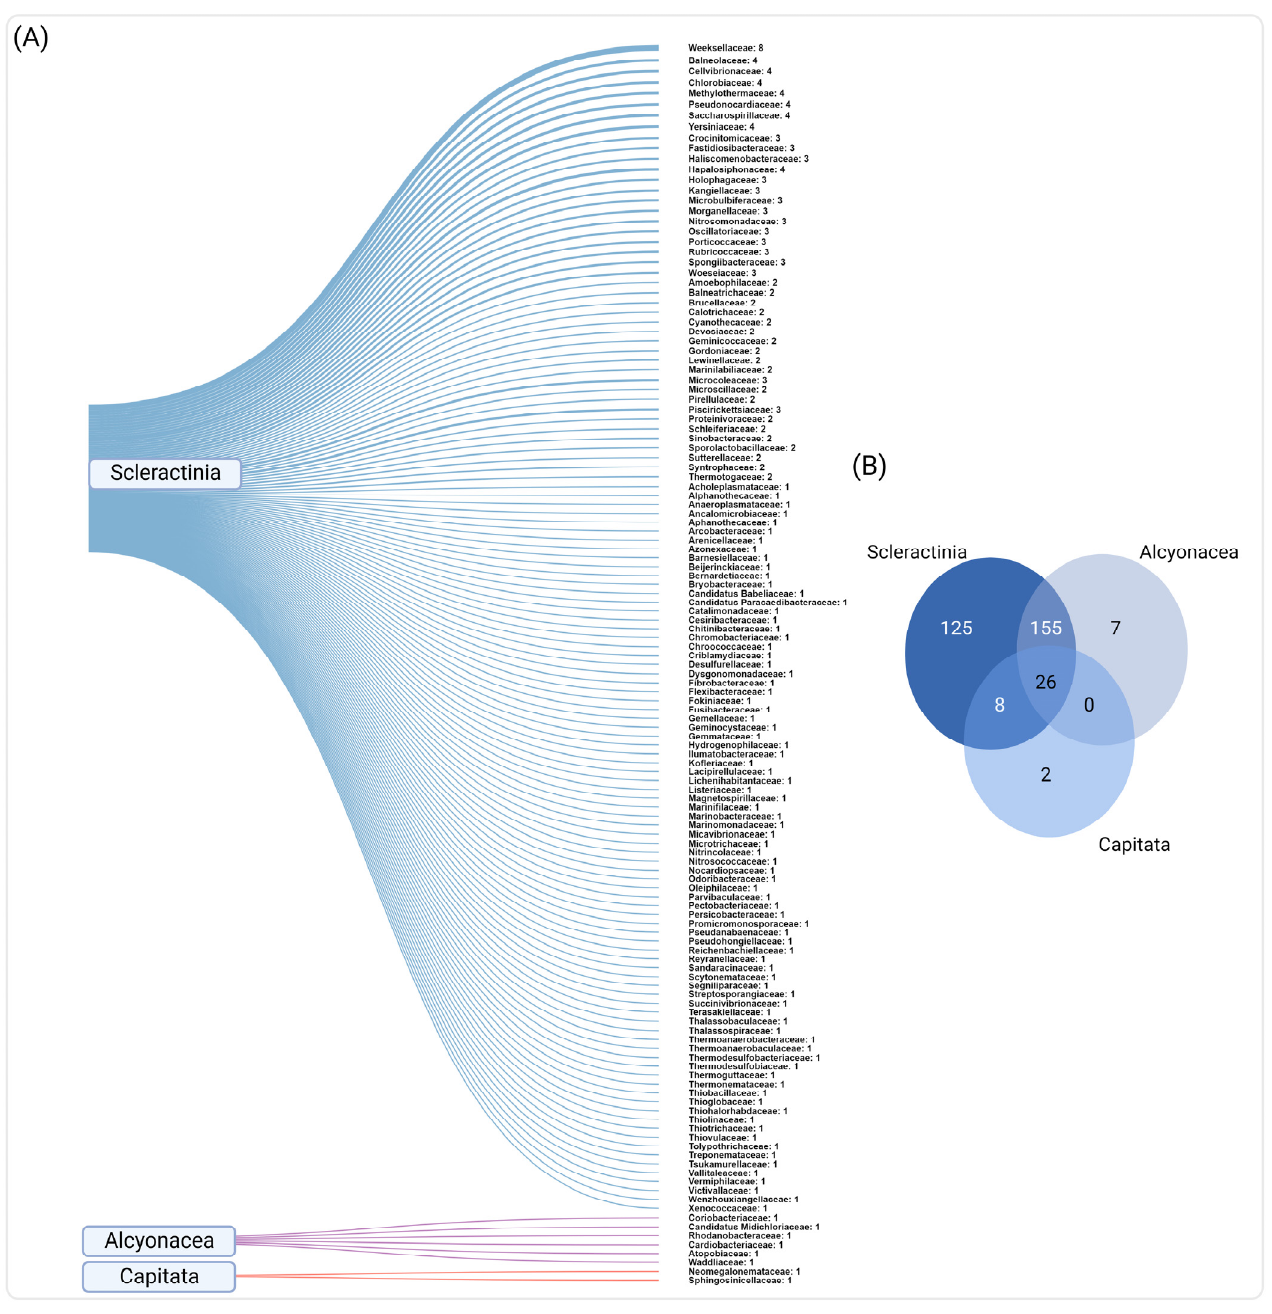
Figure 5. Bacterial families exclusively identified according to the coral order. ( A ) Sankey diagram showing the families exclusively associated with hard corals and hydrocorals ( Scleractinia and Capitata ) and soft corals ( Alcyonacea ). The number each bacterial family was reported across studies is shown. ( B ) Venn diagram showing the number of common and exclusively reported bacterial families among coral orders.